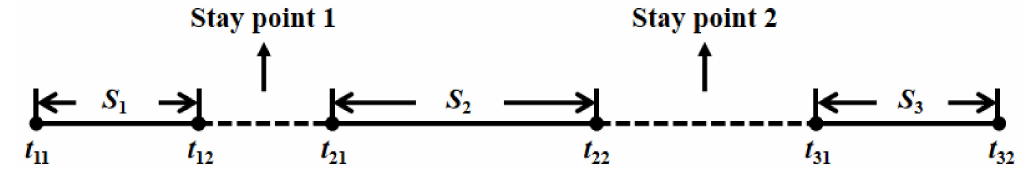
Figure 7. A taxi suborder that has two stay points (or possible transfer points) whose parking duration is more than 5